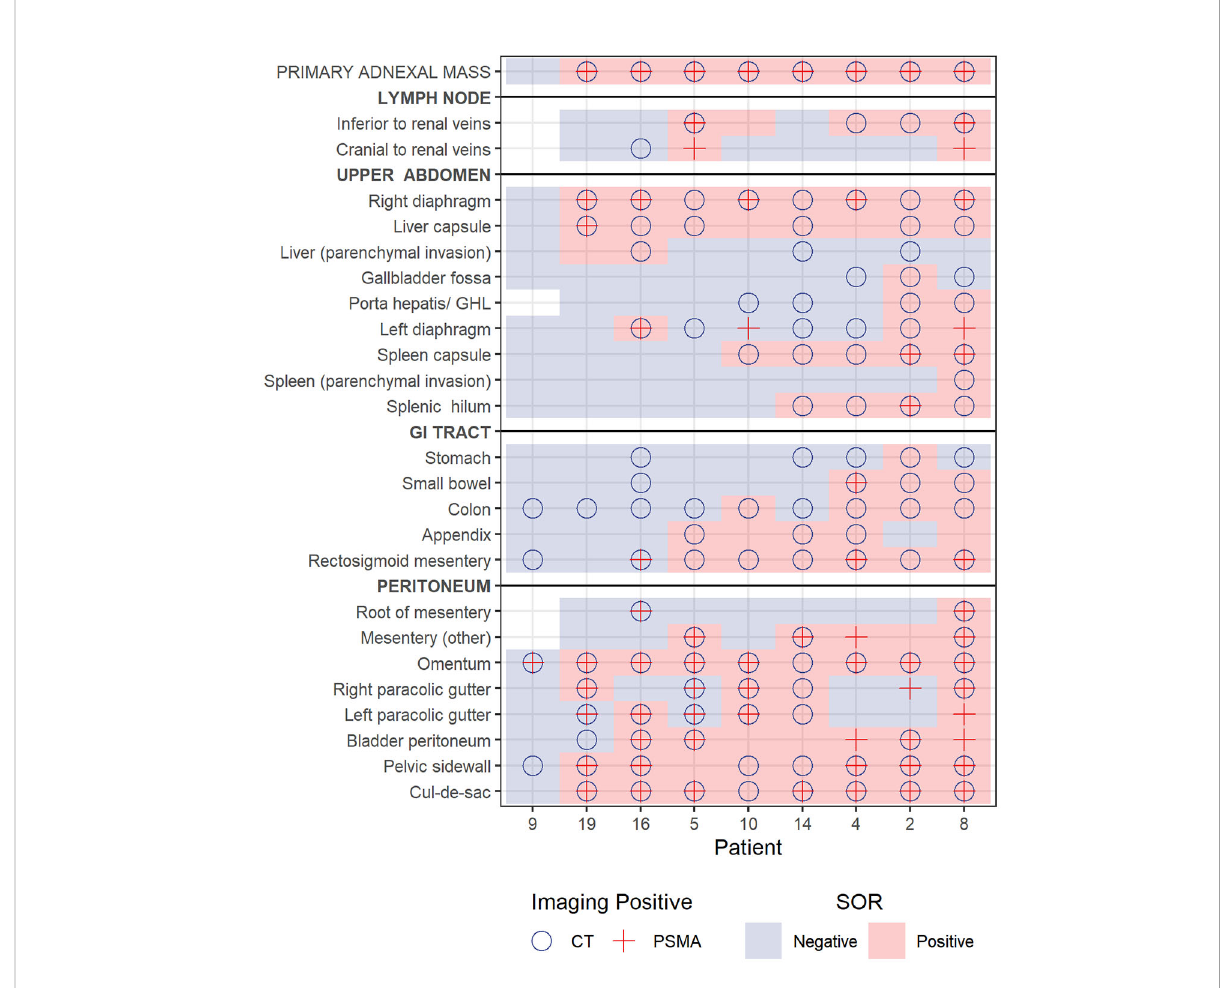
FIGURE 2 Plot showing lesion detection by site for each of the 9 patients who underwent primary cytoreductive surgery. Blue background and pink background denote negative or positive station according to reference standard, respectively. A circle notes positive on CT and cross notes positive on PET.